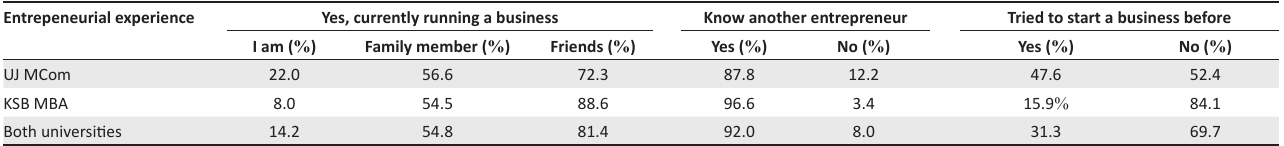
TABLE 4b: Profiles – University of Johannesburg MCom students versus Krakow School of Business MBA students. Entrepeneurial